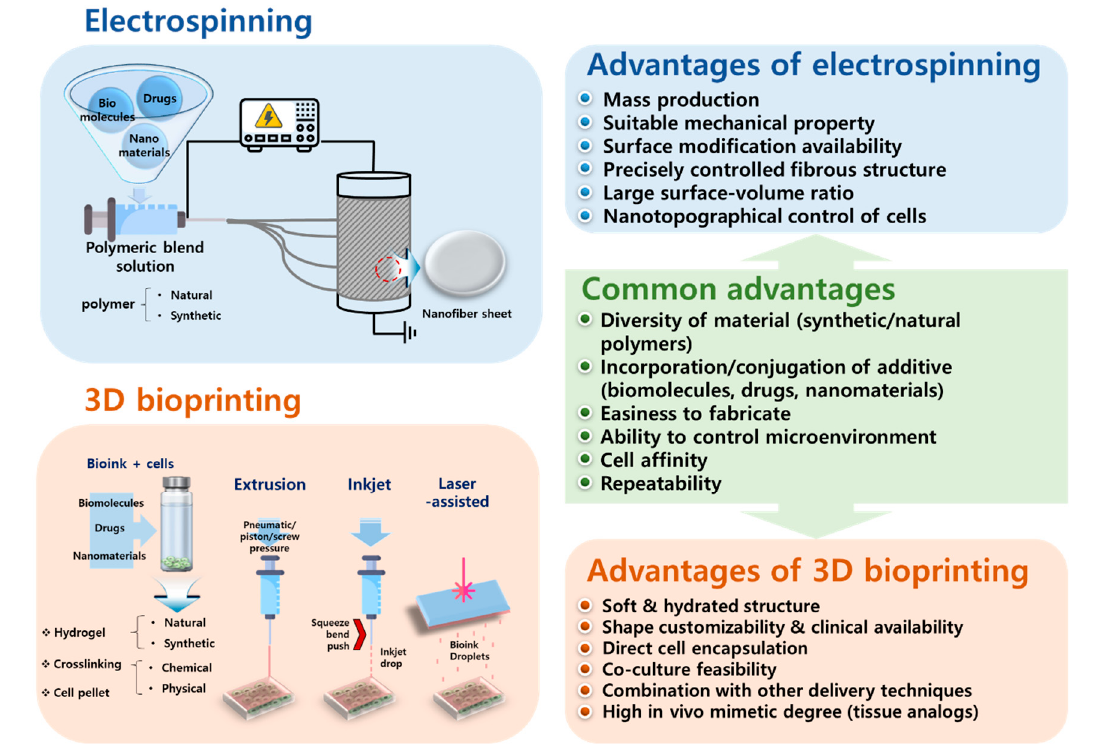
Figure 1. Relative comparison of technical advantages between electrospinning and 3D bioprinting to engineer skeletal muscle tissue constructs.